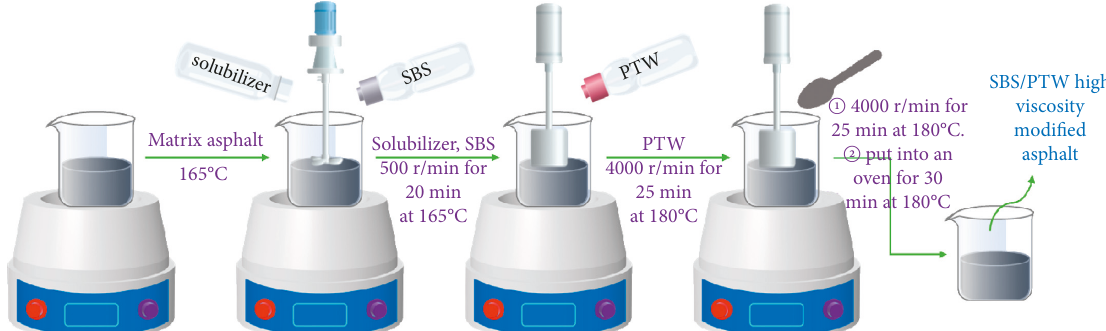
Figure 1: Preparation process of SBS/PTW high-viscosity-modified